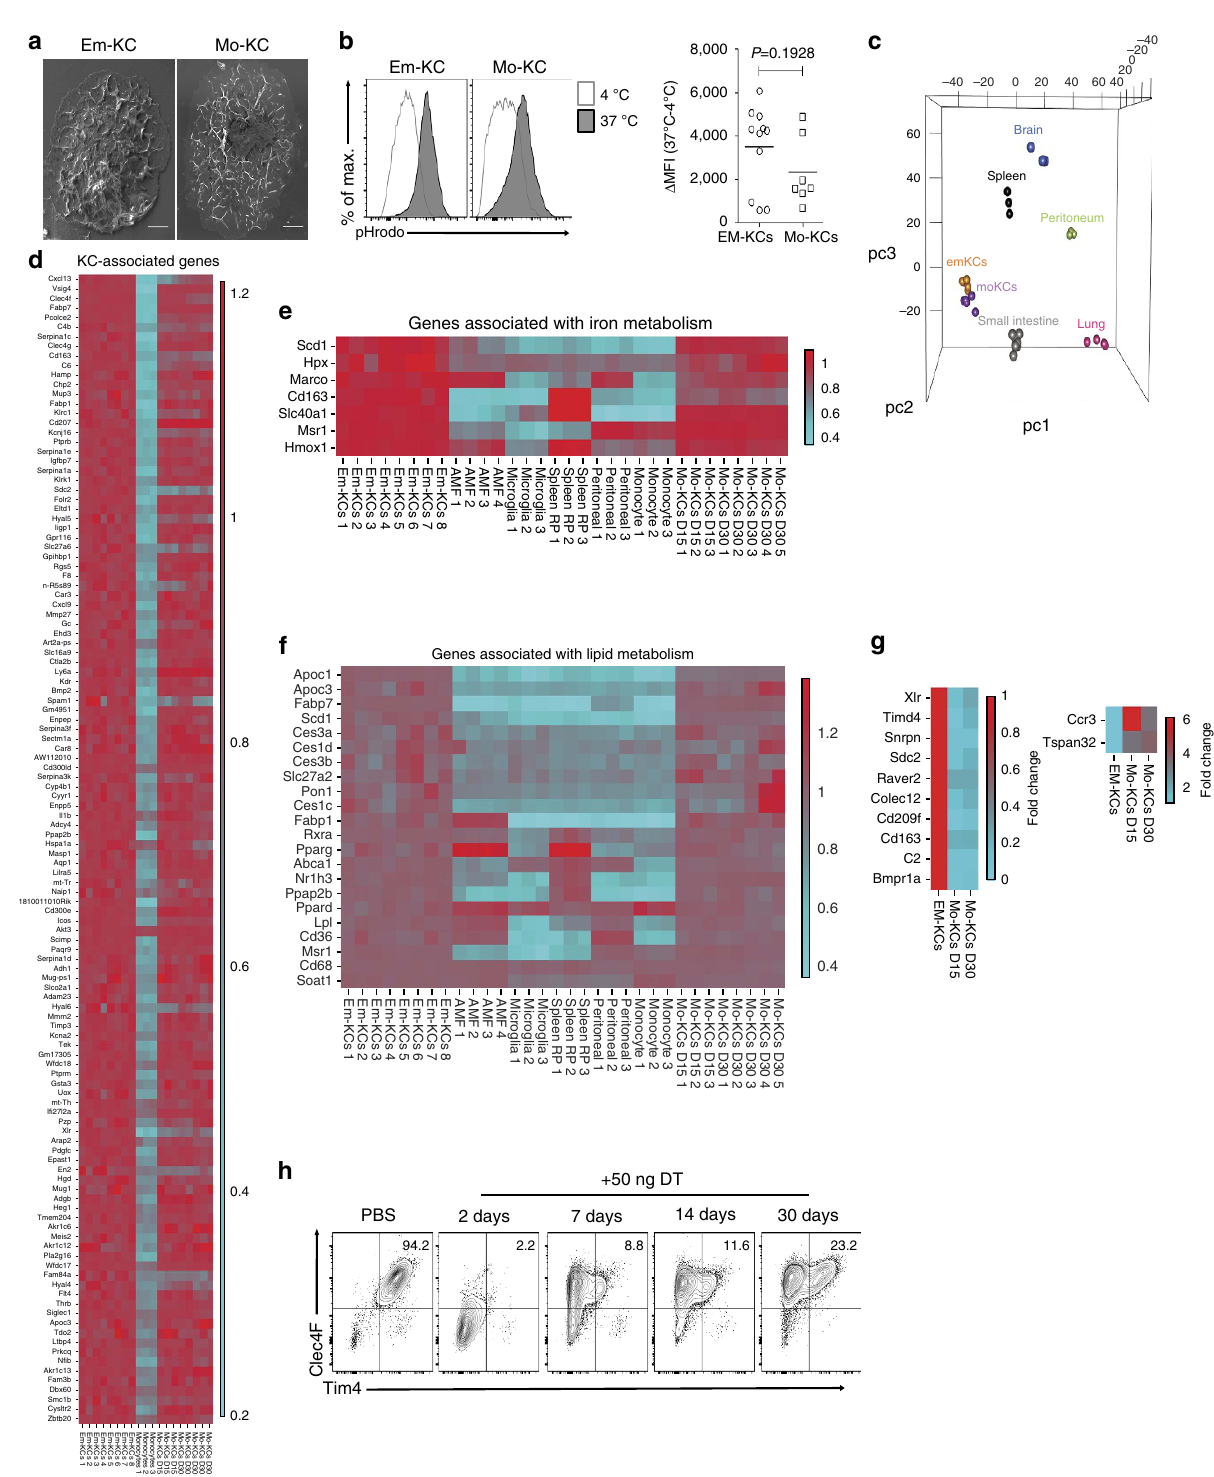
Figure 5 | Mo-KCs are highly homologous to em-KCs. ( a ) SEM imaging of em-KCs and mo-KCs 30 days post DTadministration. Scale bar, 4 m m. Images are representative of n ¼ 3 per group. ( b ) Uptake of E. coli bioparticles conjugated to the pH-sensitive fluorescent pHrodo dye by em-KCs and day 7 mo-KCs shown as D mean fluorescence intensity at 37–4 (cid:2) C (control). Data are pooled from two experiments. n ¼ 7 (mo-KCs) or 11 (em-KCs). P ¼ 0.1928 Two-way Student’s t -test. ( c ) Principle component analysis of em-KCs, mo-KCs (pooled day 15 and day 30 post DT) sorted as shown in Supplementary Fig. 5b and other tissue-resident m f populations sorted by the Immgen Consortium. ( d – g ) Heatmap of fold change in expression of ( d ) top 100 genes enriched in Em-KCs when compared with all other tissue-resident m f populations and blood Ly6C hi MHCII (cid:2) monocytes, which were sorted and arrayed by the Immgen Consortium ( e ) core iron metabolism genes enriched in em-KCs ( f ) core lipid metabolism genes enriched in em-KCs and ( g ) all genes differentially expressed by at least 1.5-fold between em-KCs and mo-KCs at day 30. In all heatmaps, mean expression of each gene by em-KCs was set at one. ( h ) Clec4Fand Tim4 expression by live CD45 þ CD11b þ Ly6C (cid:2) F4/80 þ liver cells measured at 2, 7, 14 and 30 days post DTadministration. Data are representative of 1–3 experiments at the various time-points with n ¼ 2–4 per